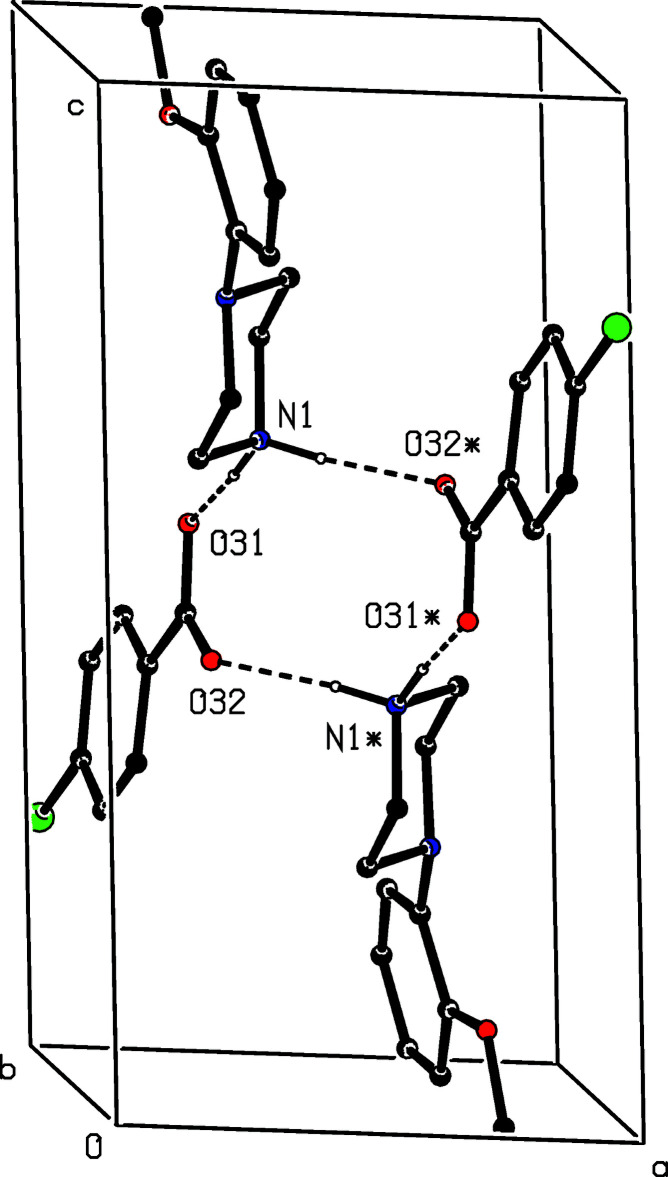
Part of the crystal structure of compound (I) showing the formation of a centrosymmetric four-ion aggregate. Hydrogen bonds are drawn as dashed lines and, for the sake of clarity, the H atoms bonded to C atoms have been omitted. The atoms marked with an asterisk (*) are at the symmetry position (1 − x, 1 − y, 1 − z).